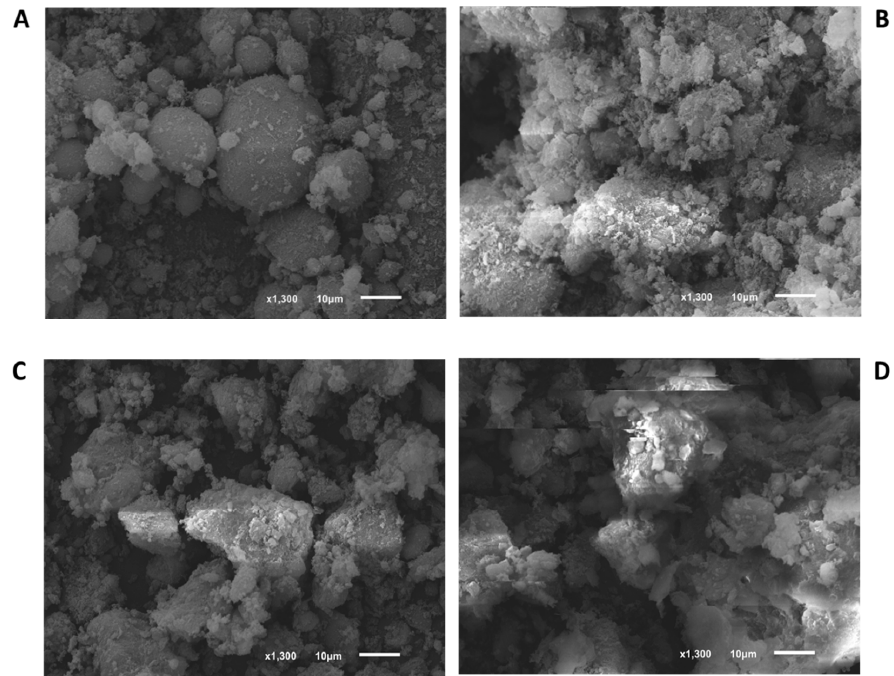
Figure 3. SEM images of Basolite A100 (zoom in 10 µm) ( A : original, B : 55.9 MPa, C : 111.8 MPa, D : 186.3 MPa).